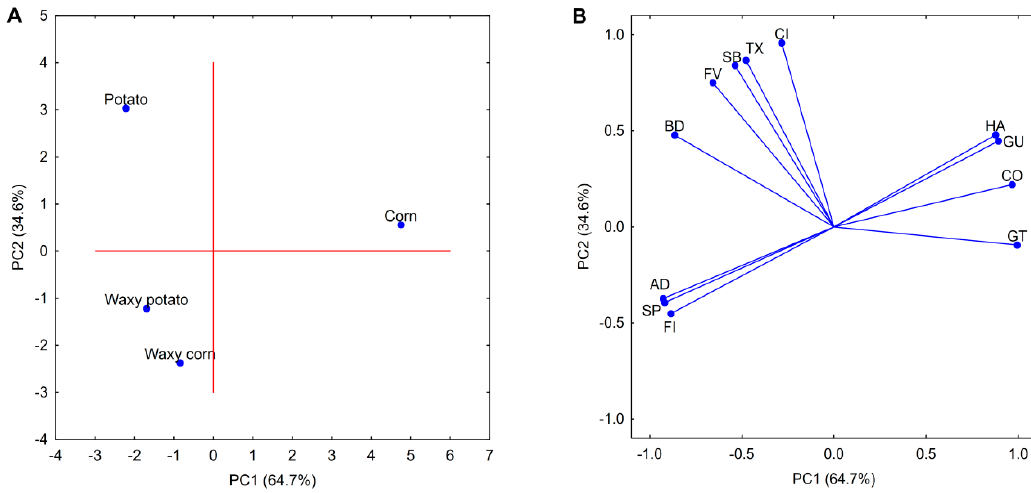
Figure 1. Principal component analysis (PCA) score ( A ); loadings plot ( B ); rheological and texture